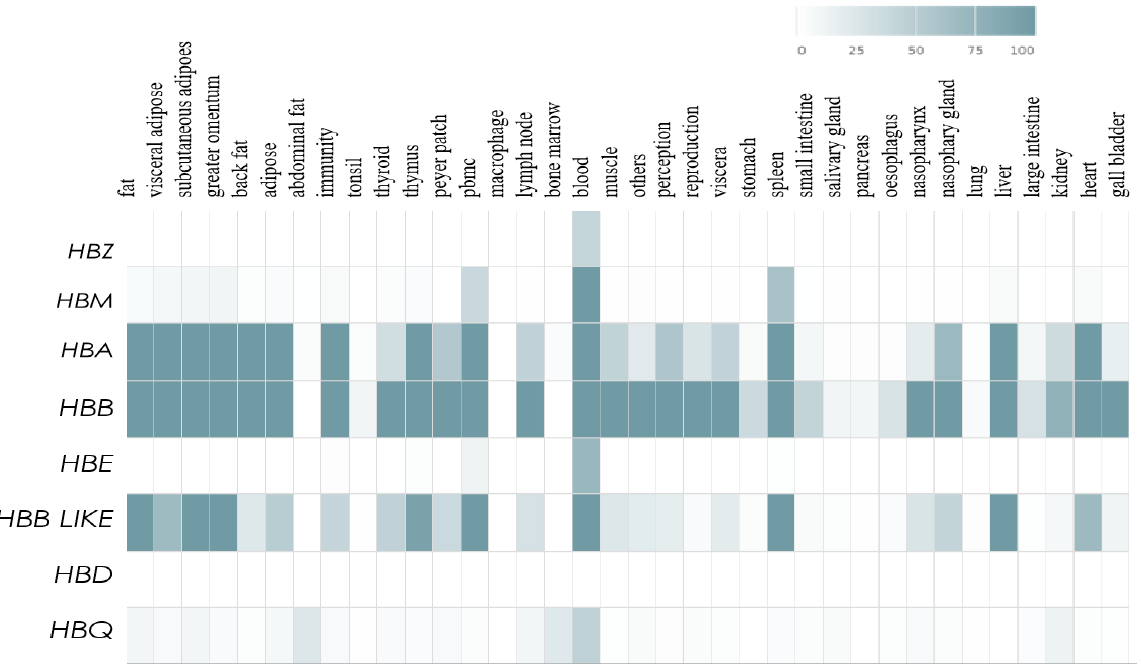
Figure 3. Expression patterns of the eight porcine hemoglobin-encoding genes in the iswine